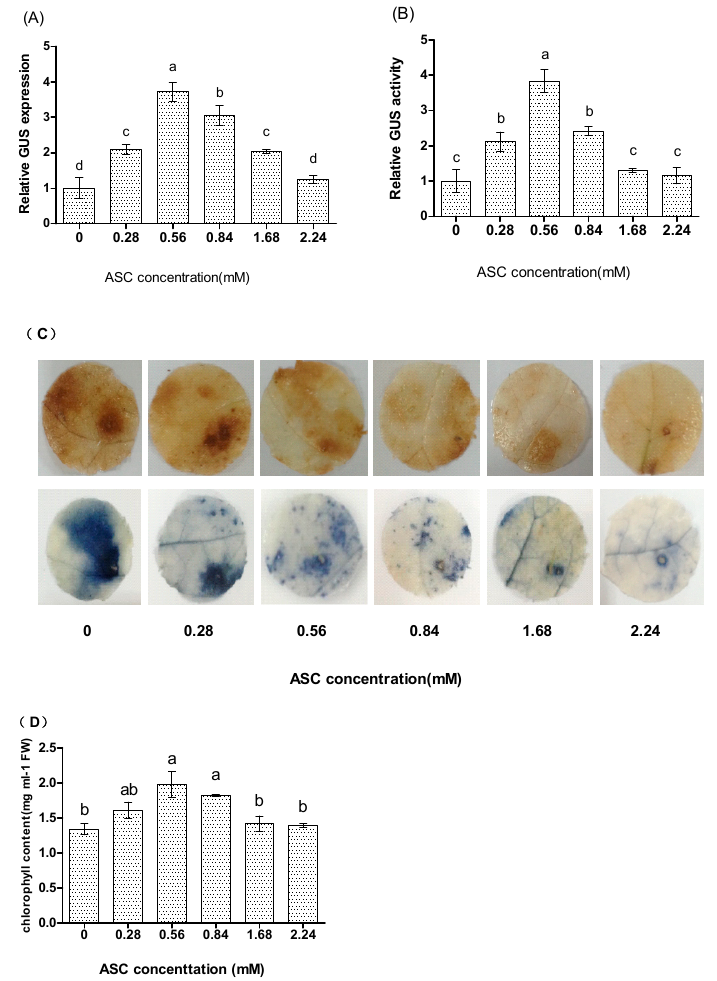
Figure 2. The effects of Ascorbate acid (ASC) on transformation efficiency by monitoring the expression of the GUS reporter gene ( A ) and GUS activity ( B ). ( A ) GUS expression analysis to study the transformation efficiency. GUS expression at different levels of ASC treatment was normalized by that in the control experiment (no ASC was supplied); ( B ) Determination of the effects of ASC on syringe agroinfiltration efficiency by GUS activity analysis. The activity of GUS in the control (without ASC supplement) experiment was used to normalize the activity of GUS at different concentrations of ASC. a, b, c, d means not sharing a common superscript differ significantly according to ANOVA Tukey’s test ( p < 0.05); ( C ) Analysis of reactive oxygen species (ROS) scavenging by supply of ASC. Detection of ROS by 3-diaminobenzidine (DAB) and nitroblue tetrazolium (NBT) staining that respectively indicate the level of H 2 O 2 and O 2 − ; ( D ) Analyses of chlorophyll contents in the infiltrated leaves supplied with different concentrations of ASC.